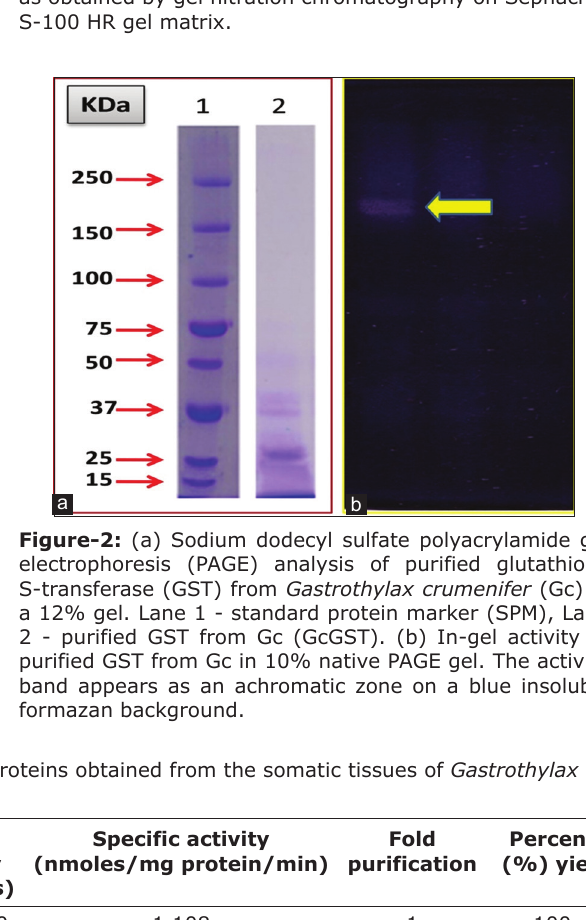
Figure-1: Elution profile of 40-60% ammonium sulfate precipitated protein fraction of Gastrothylax crumenifer